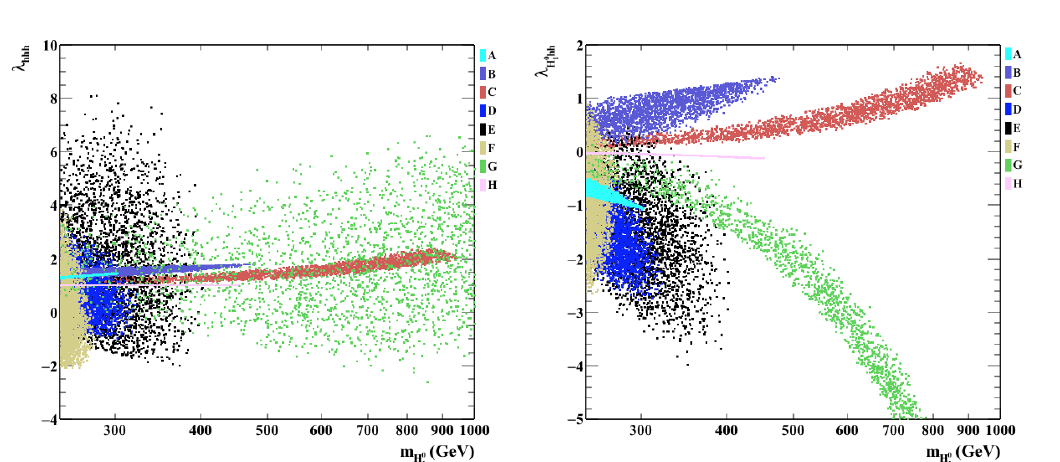
Figure 4 . Scatter plots of scalar couplings (cid:21) hhh (left) and (cid:21) in (cid:12)gure 4 the scatter plots of (cid:21) point. The trilinear self-coupling of h can signi(cid:12)cantly deviate from the SM value, and even (cid:13)ip its sign in benchmark points D, E, F and G, resulting in a wide range of possible values. For the coupling of H 0